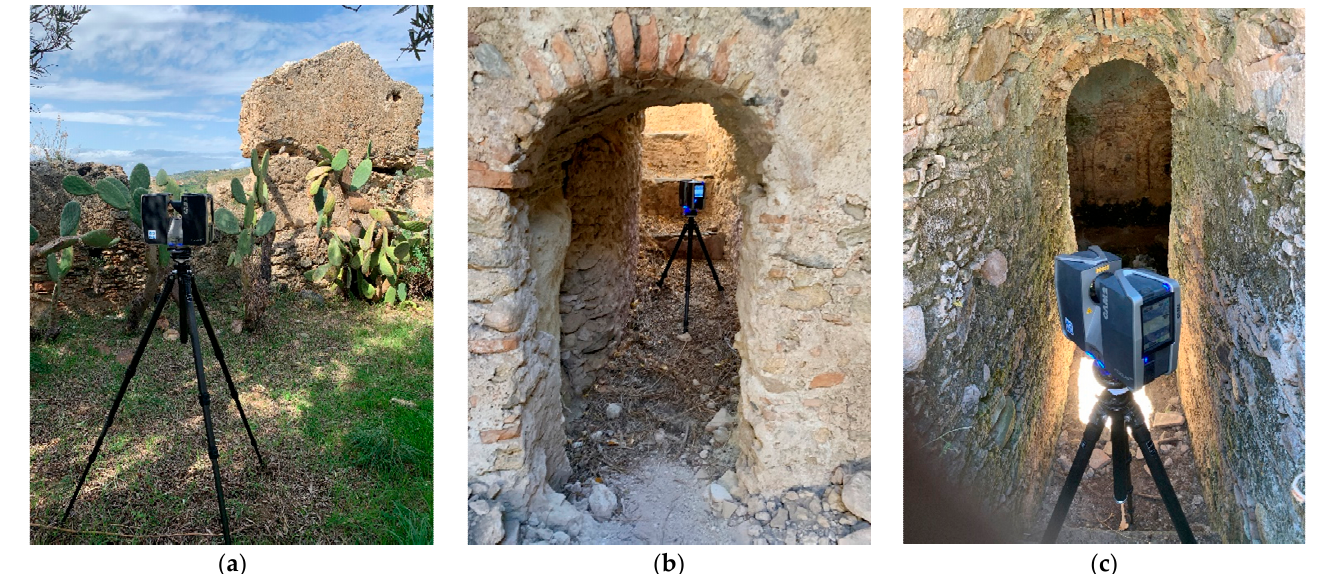
Figure 10. ( a ) TLS data acquisition: rear external space; ( b ) northern corridor; ( c ) central burial chamber.